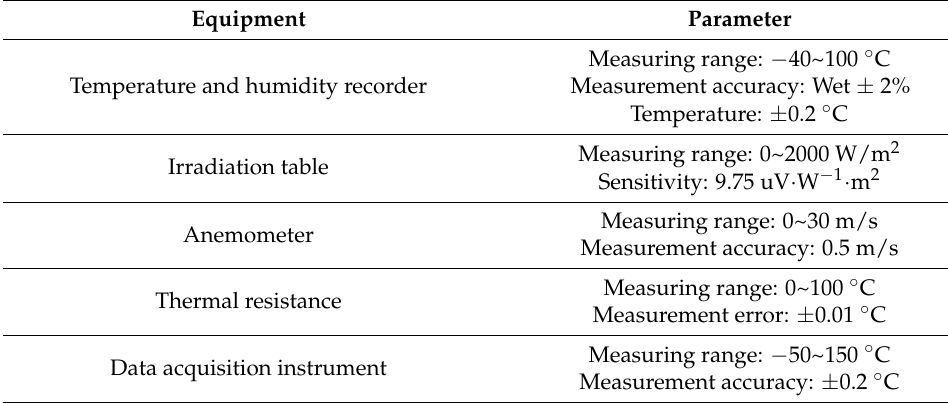
Table 2. Table of Experimental Equipment.